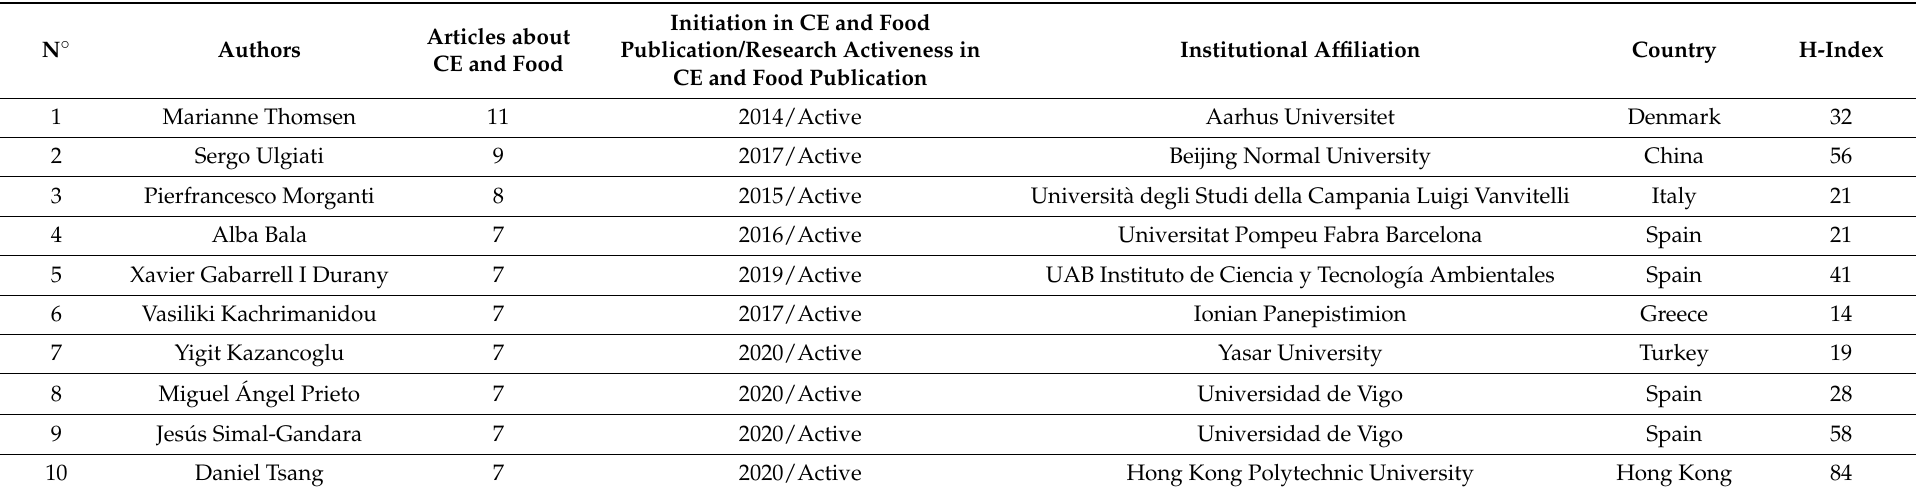
Table 6. Top 10 authors of articles on circular economy and